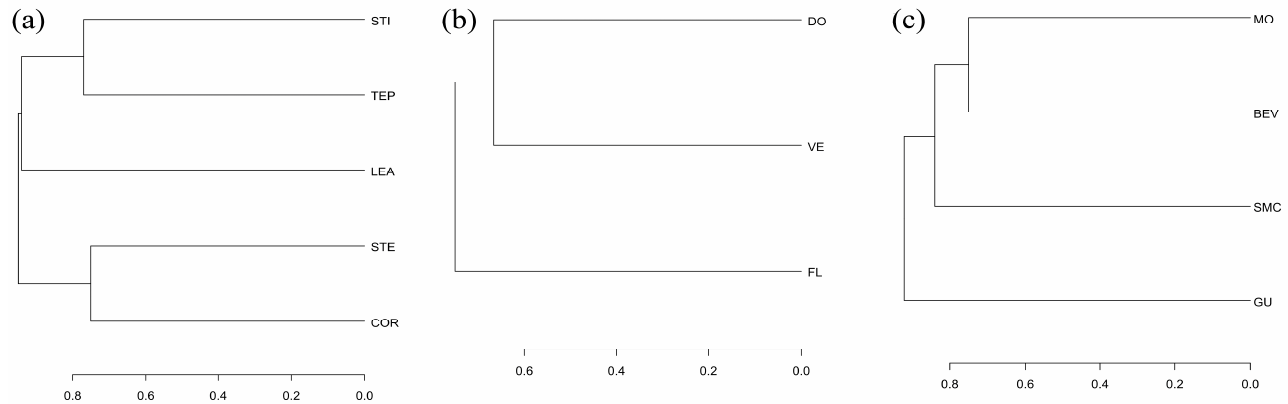
Figure 3. Cluster analysis, based on Jaccard dissimilarity values, of different tissues ( a ), life stages ( b ), and sites ( c ). STI = stigmas, TEP = tepals, LEA = leaves, STE = stems, COR = corms, DO = dormant, VE = vegetative, FL = flowering, MO = Moiano, BEV = Cantalupo di Bevagna, SMC = S. Martino in Colle, and GU = Gualdo Cattaneo.